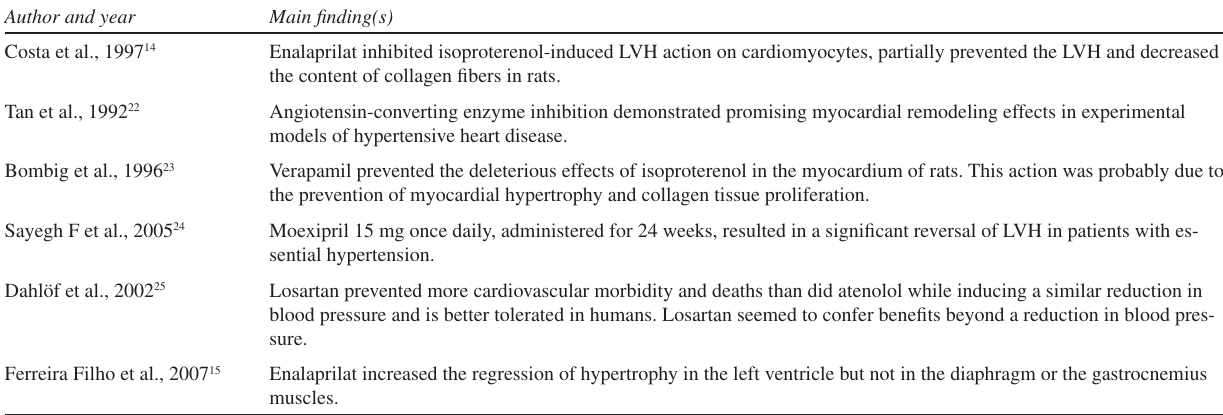
Table 1 - A summary of the main clinical and experimental studies for anti-hypertensive drugs and left ventricular hyper- trophy